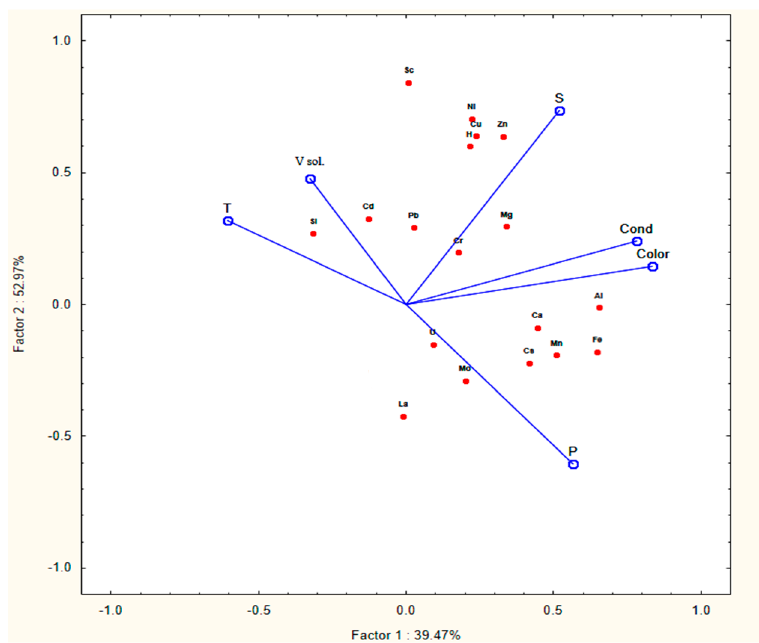
Figure 5. Redundancy analysis based on dependent (points) and independent (axis) variables.